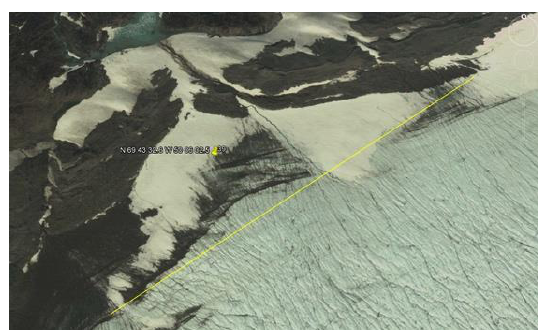
Figure 3. Area of interest on satellite image, expedition camp Nr.39, end of inland glacier (Google Earth)